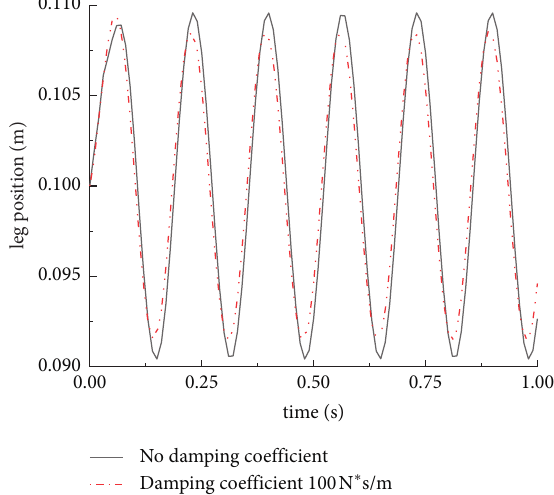
Figure 17: The displacement of branch 1 (constant stiffness coefficient 9830 N/m).